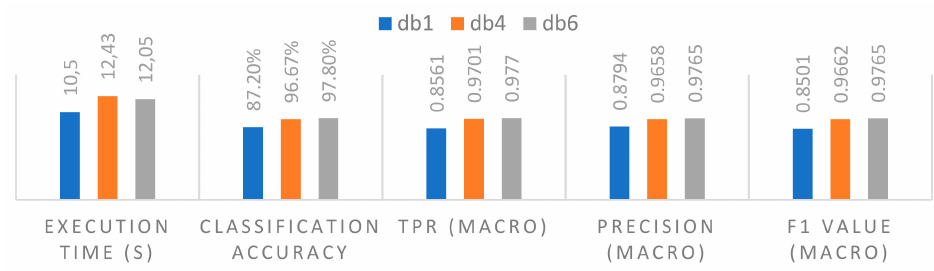
Figure 8. Classification model performance results.